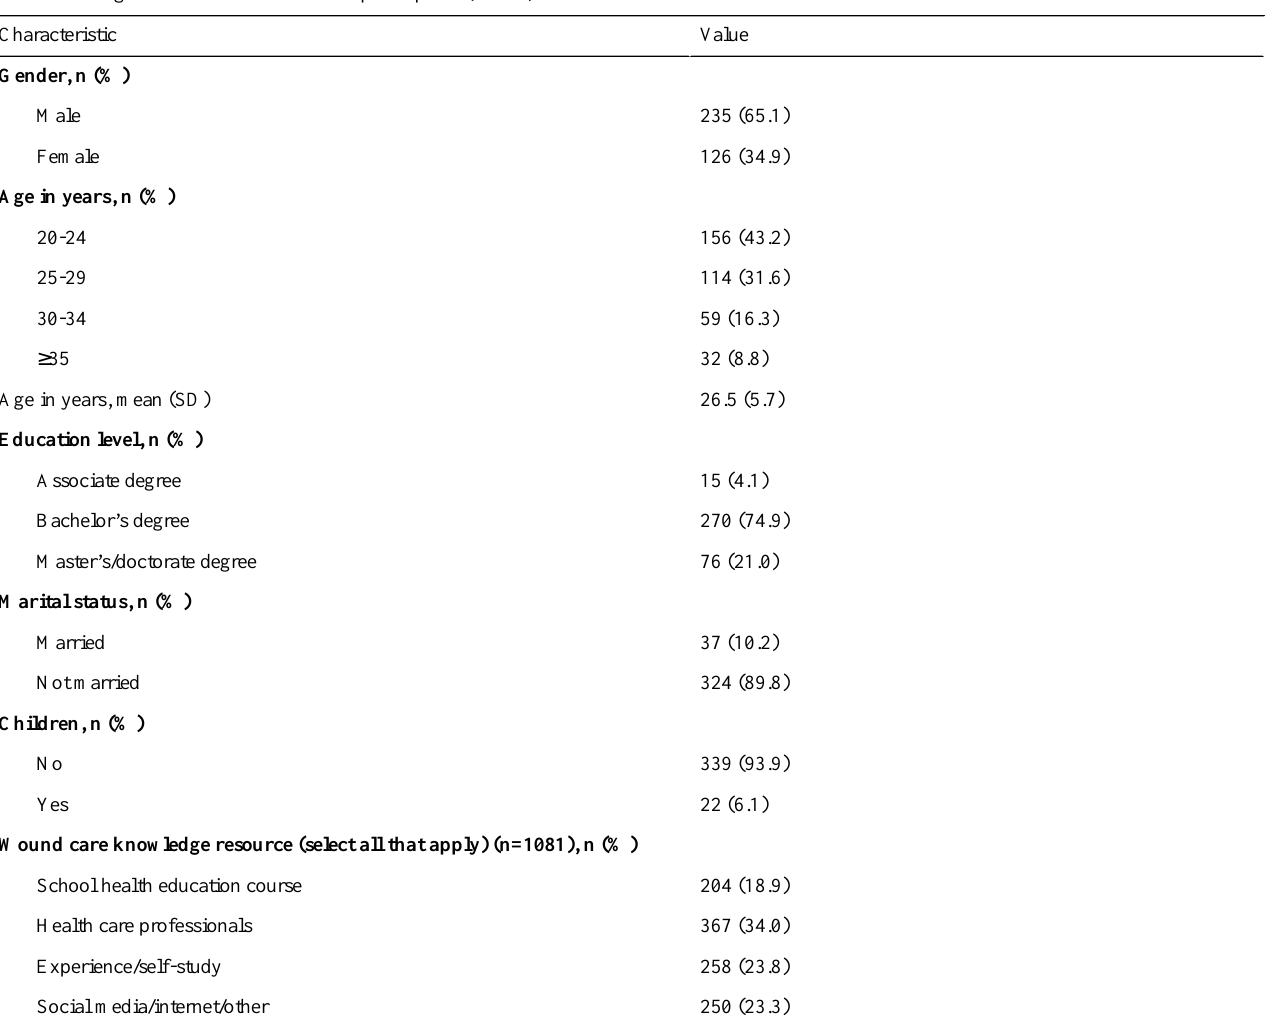
Table 1. Background characteristics of the participants